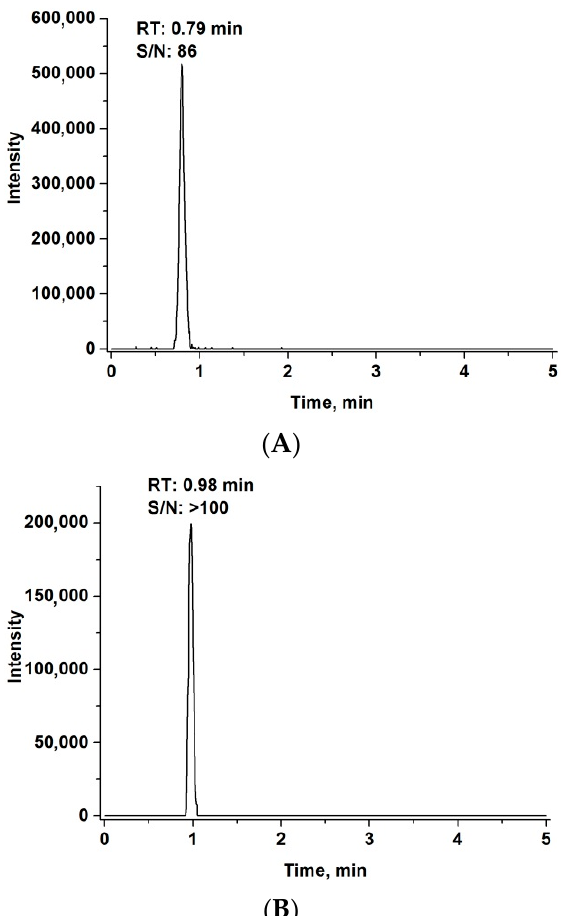
Figure 4. LC–HRMS chromatograms of ( A ) the LOQ of atenolol (5 ng/mL) and ( B ) the IS (0.2 ng/mL) with corresponding retention times (RT) and signal-to-noise ratios.